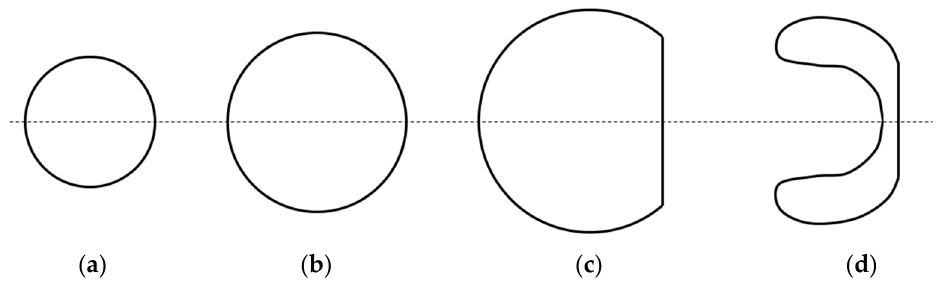
Figure 6. Representation of steps of bubble mid-sectional shape change starting from its conception ( a ), expansion due to increase in inner gas pressure ( b ), flattening on rigid surface and attainment of maximum volume ( c ), to the collapsing toroidal shape ( d ).